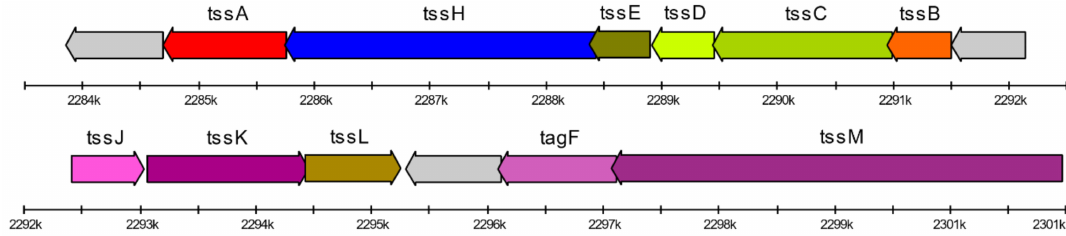
Figure 3. Schematic diagram of the genetic organization of the type VI secretion system main gene cluster in the Janthinobacterium sp. SLB01